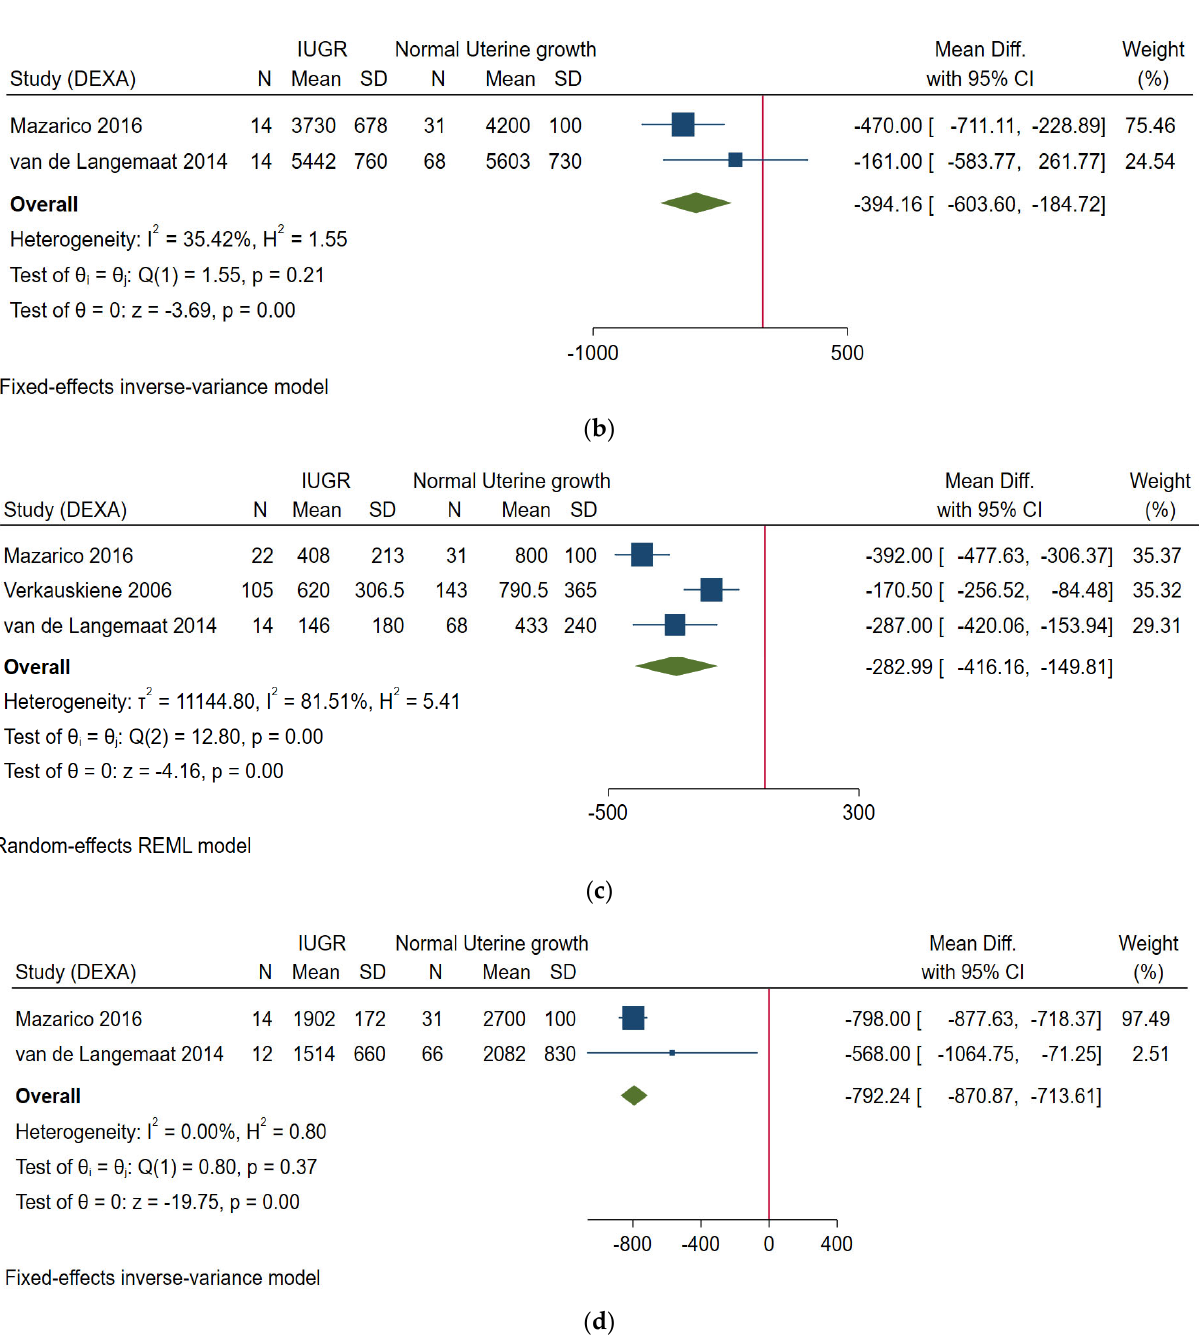
Figure 2. Forest plot showing mean differences between IUGR and normal intrauterine growth infants, in ( a ) FFM ‐ neonatal period; ( b ) FFM ‐ from 6 weeks to 6 months of age; ( c ) FM ‐ neonatal period; ( d ) FM ‐ from 6 weeks to 6 months of age.